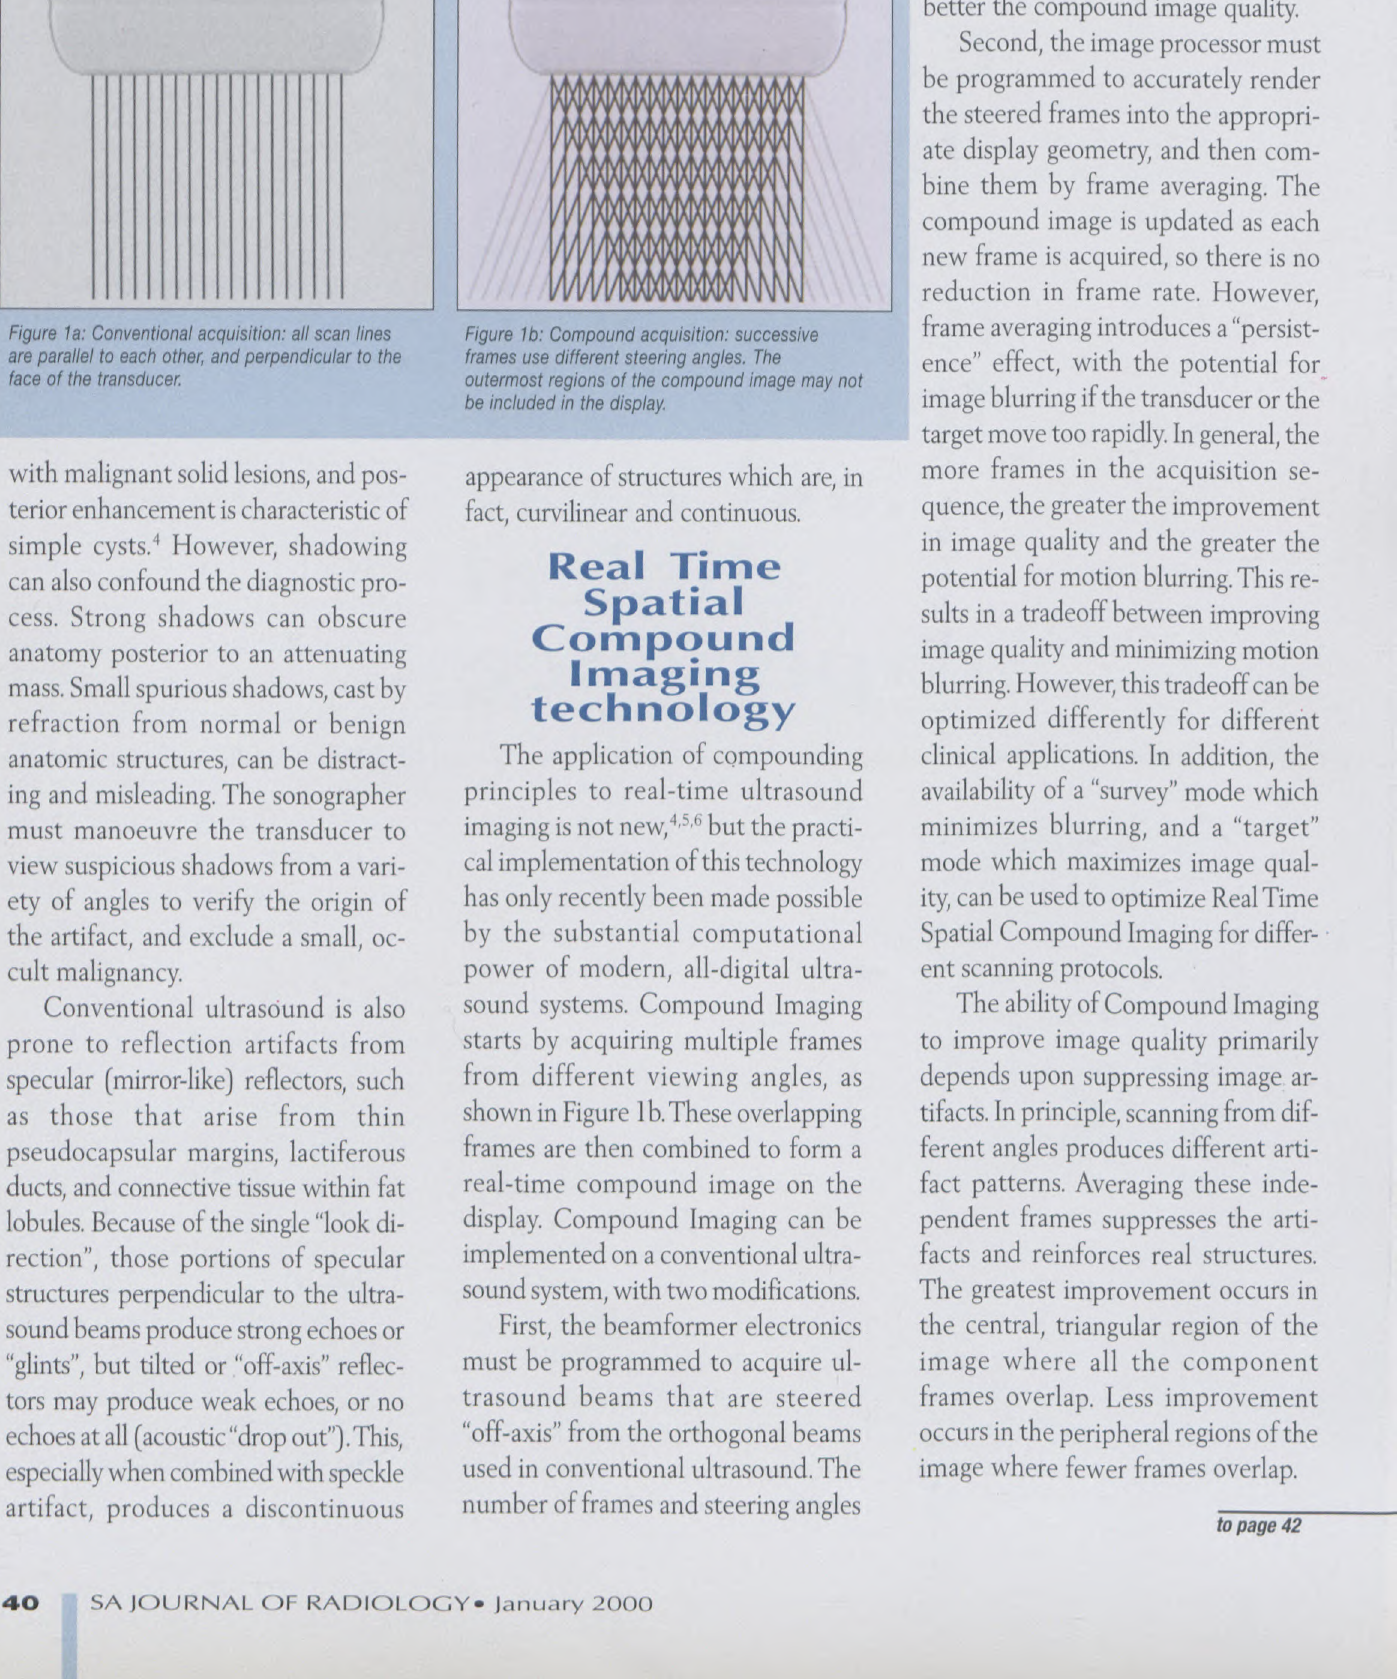
Figure la: Conventional acquisition: all scan lines are parallel to each other, and perpendicular to the face of the transducer.